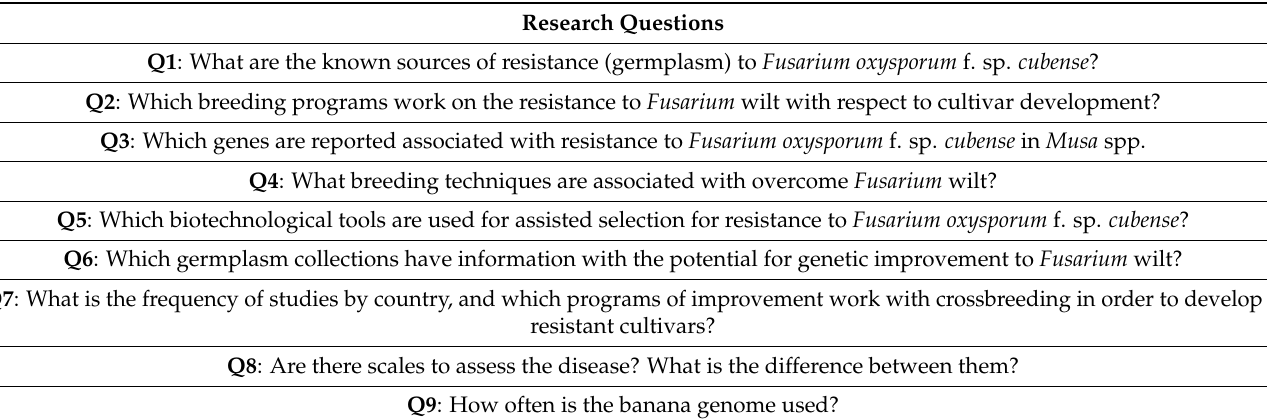
Table 1. List of questions about the genetic improvement of Musa for resistance to Fusarium wilt to be answered by a systematic review of studies carried out in the last ten